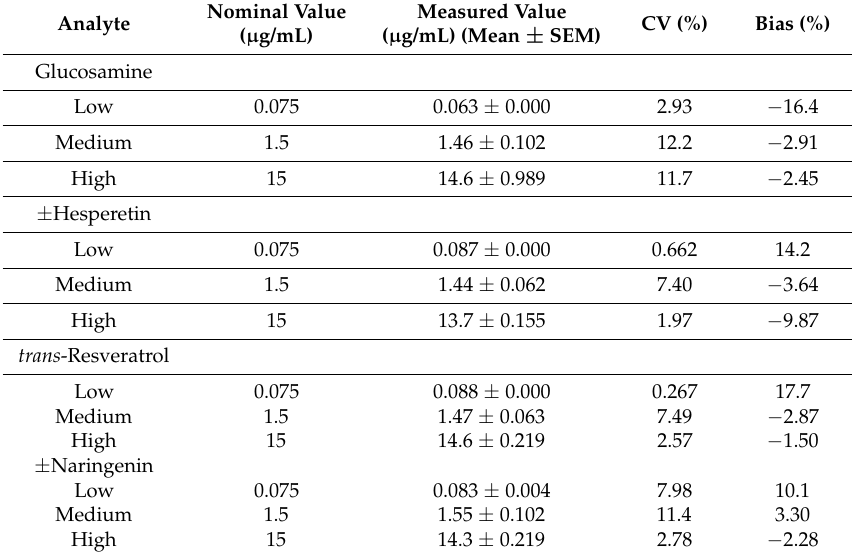
Table 3. Accuracy and precision of the LCMS quantitative analysis of glucosamine, ± hesperetin, trans -resveratrol and ± naringenin ( n =